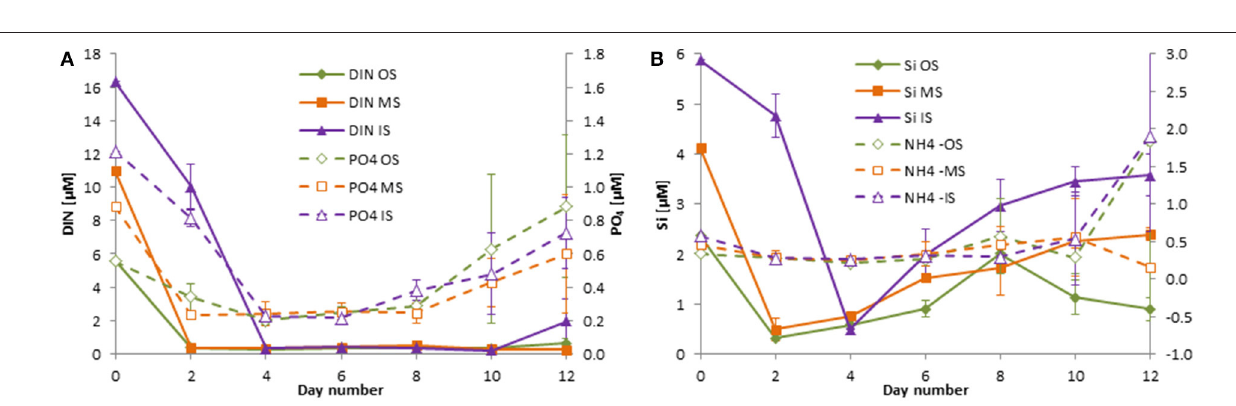
FIGURE 5 | Development of the concentrations of DIN and DIP (A) as well as silicate and ammonium (B) in the tanks of the experiment from summer 2014 (cruise M103/2). Mean values and standard deviations of the three replicate tanks are